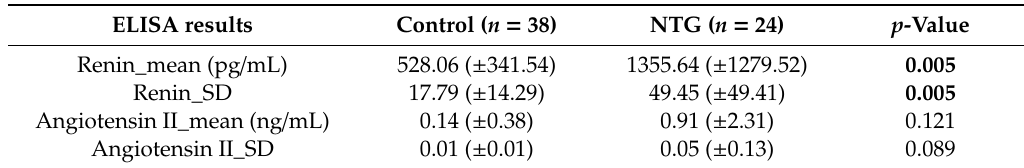
Table 2. Comparison of the blood examination of the control group and the normal tension glaucoma (NTG) group.